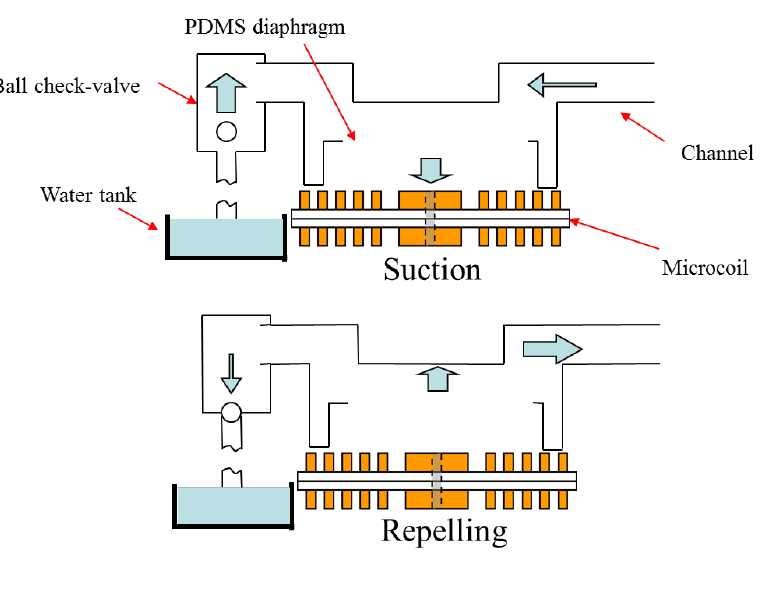
Figure 1. Operating principle of reciprocating